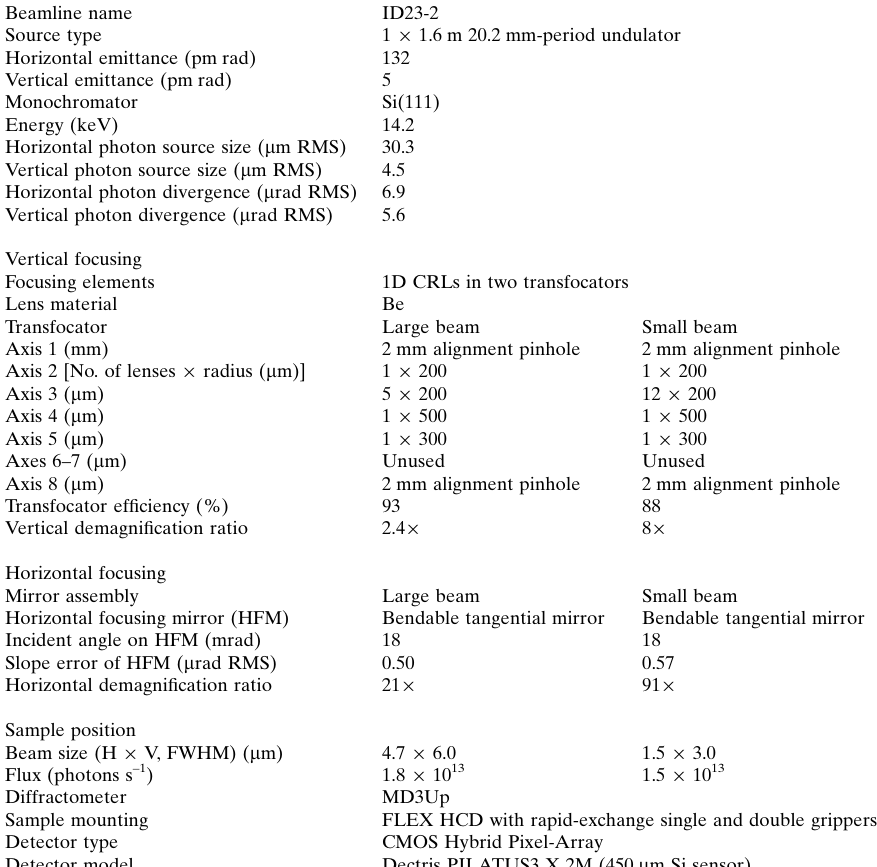
Table 1 Summary of the beamline parameters, including source, optical configuration, X-ray beam characteristics and the experimental setup for ID23-2 at the